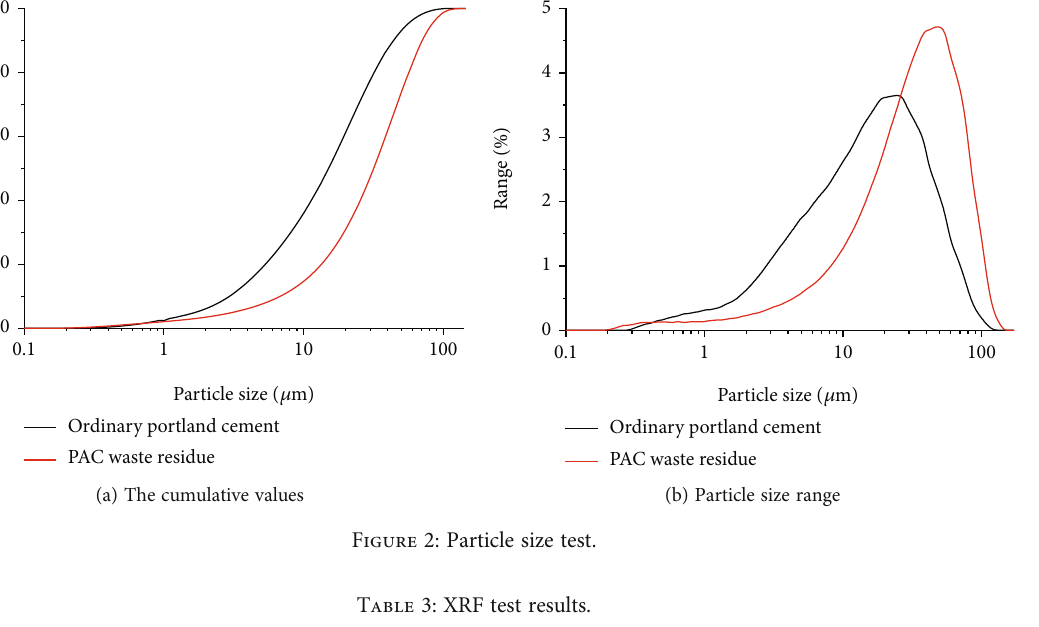
Figure 2: Particle size Table 3: XRF test results.